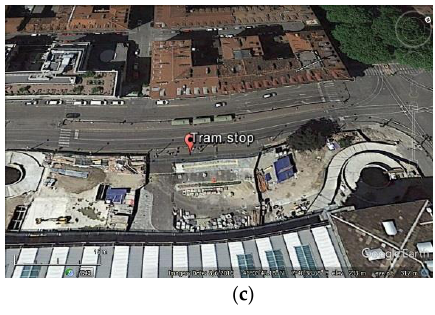
Figure 8. Case-study A. Narrow-band interferer detected on 6 March 2017 at 15 h:26 m:11 s ( a ) and 15 h:28 m:31 s ( b ) local time, at the bus stop n. 253 (Porta Nuova) in Turin ( c ).